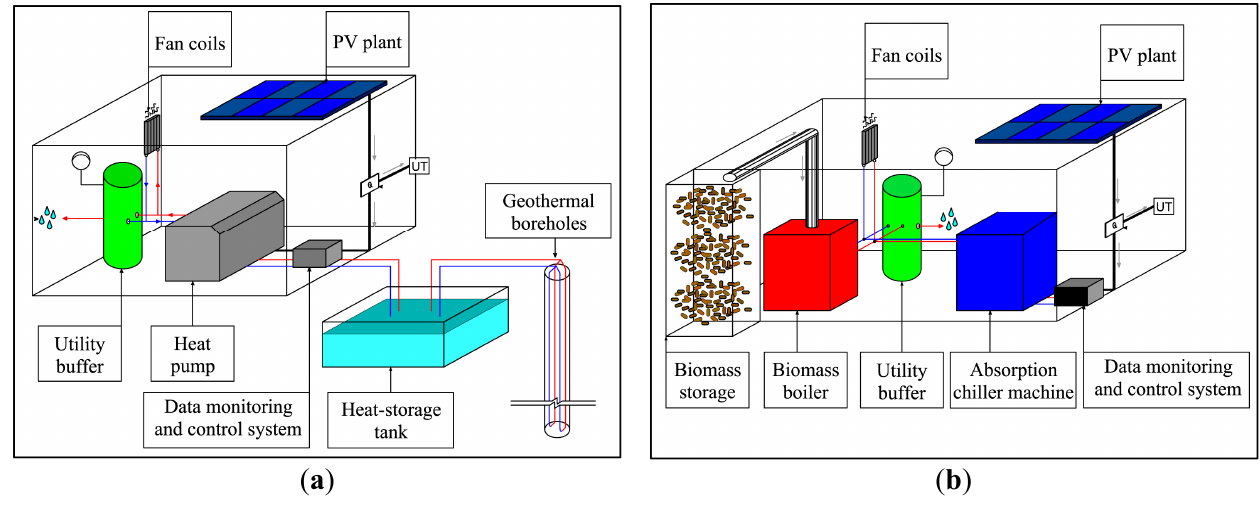
Figure 3. The proposed heating/cooling systems: ( a ) geothermal heat pump with heat-storage tank; and ( b ) biomass boiler with absorption machine; a photovoltaic plant covers electric needs in both